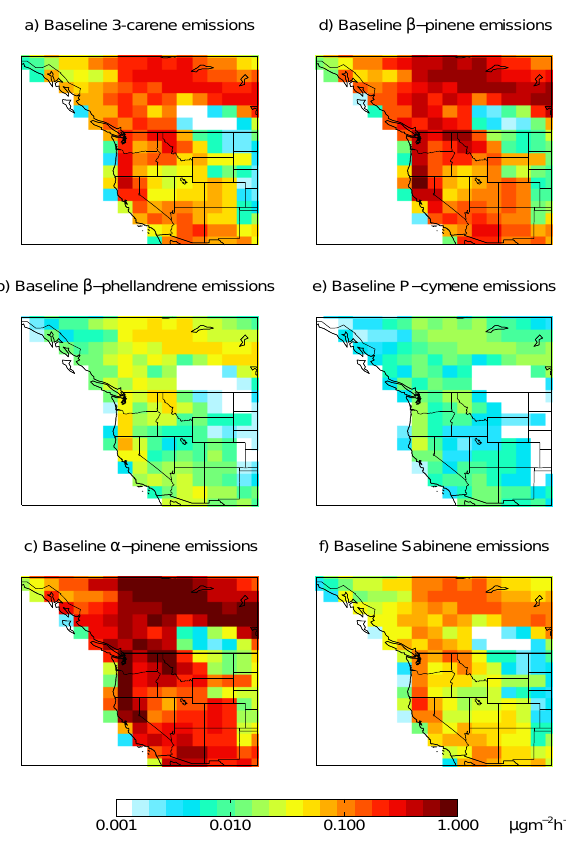
Fig. 3. Baseline summer-mean simulated emissions of monoter- penes potentially influenced by beetles: (a) 3-carene, (b) β - phellandrene, (c) α -pinene, (d) β -pinene, (e) p-cymene, and (f) sabinene. Color bar is saturated at 1µgm − 2 h − 1